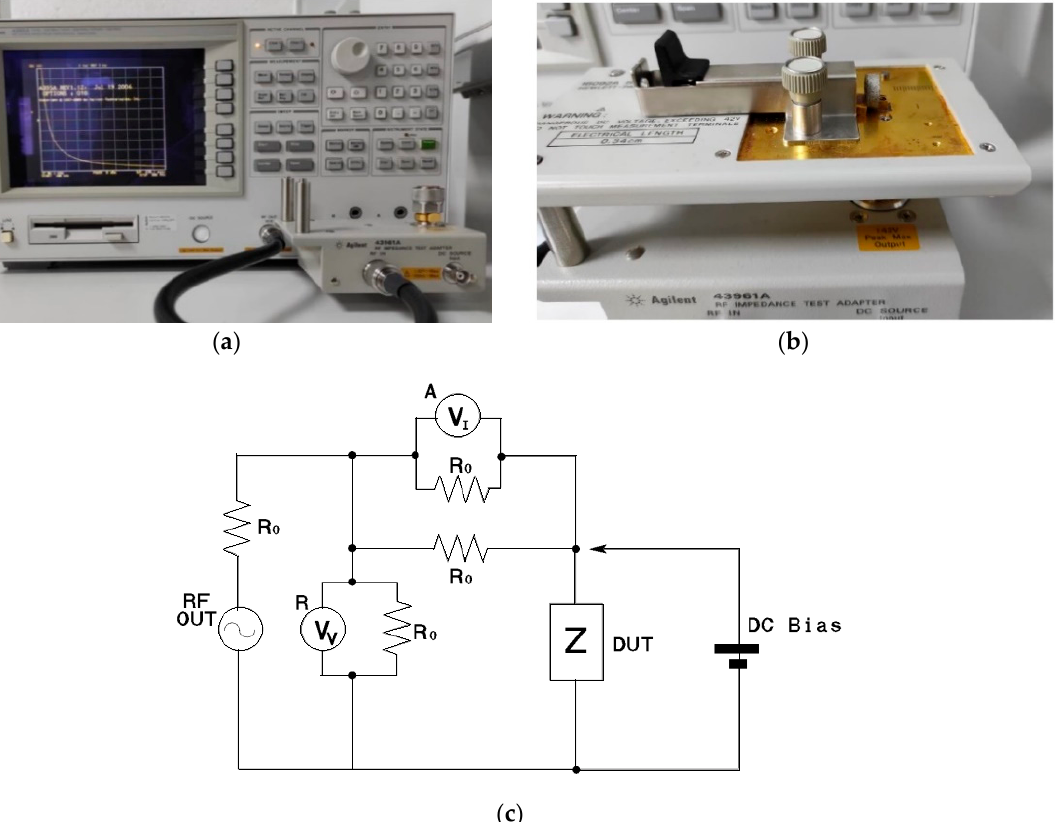
Figure 2. ( a ) impedance analyzer used (Hewlett–Packard 4395A). ( b ) placement of the sample in the HP 16,092 module. ( c ) measurement circuit used by the impedance analyzer, where the source signal is output from RF OUT port. Vv volt- meter is R port receiver that measures a voltage. Vi voltmeter is A port receiver that measures a voltage of Ro to obtain a